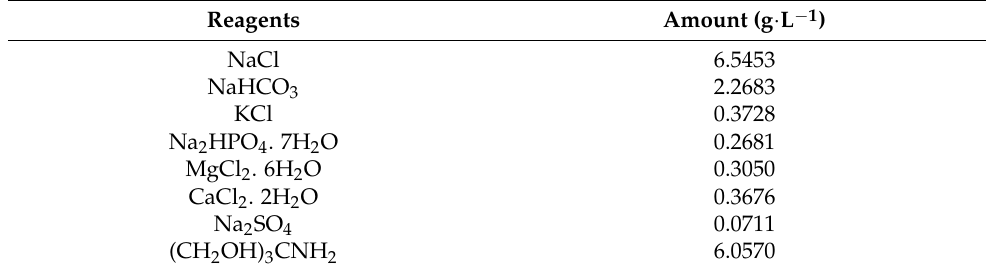
Table 1. The components of the SBF solution.